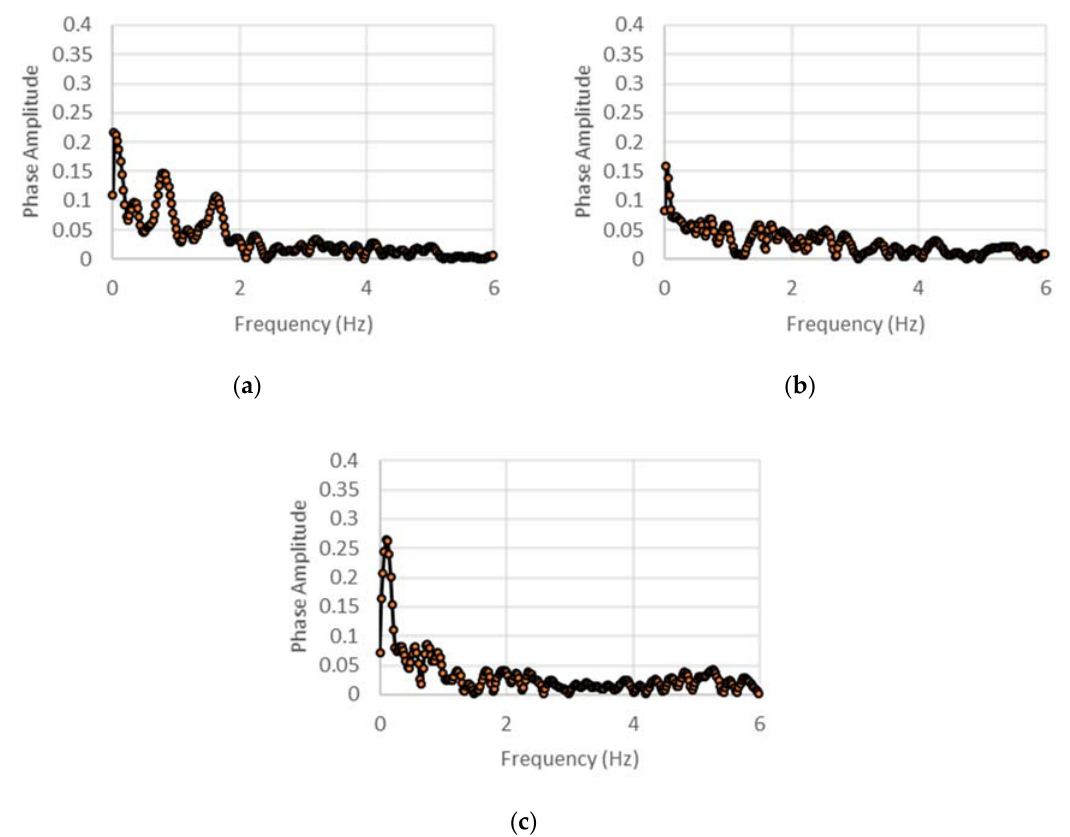
Figure 21. Phase angle spectra for ( a ) 3 Hz, ( b ) 4 Hz, and ( c ) 5 Hz for acceleration control.